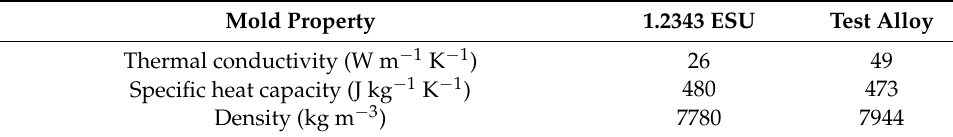
Table 1. Thermodynamic properties of the two investigated mold steels. Mold Property